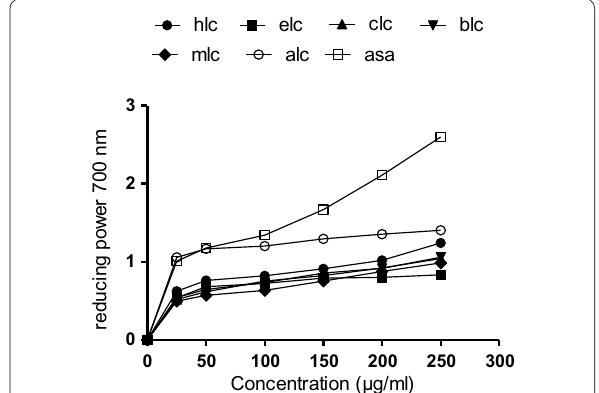
Fig. 2 Reducing power of various fractions of C. opaca leaves at dif- ferent concentrations. Each value represents a mean n -hexane fraction, elc ethyl acetate fraction, clc chloroform fraction, blc butanol fraction, mlc methanol extract, alc aqueous fraction, rt rutin, asa ascorbic